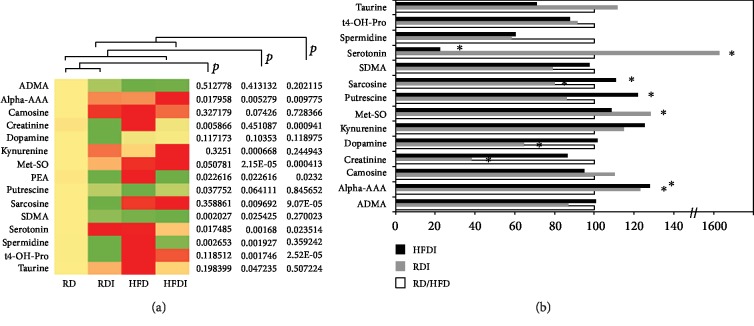
Comparison of biogenic amines profiling between T. cruzi-infected and uninfected mice fed on different diets at 150 DPI. (a) Heat map representing the serum levels of various biogenic amines during chronic infection in mice fed on either a RD or a HFD compared to uninfected RD mice at 150 DPI. Each row represents data for a specific metabolite, and each column represents the RD-fed uninfected (RD), RD-fed infected (RDI), HFD-fed uninfected (HFD), or HFD-fed infected (HFDI) mouse group. Different colors correspond to the different intensity level of metabolites (red > the control RD group and green < the control RD group). Statistically significant differences were tested using Student's t-test, and the corrected p values (q-value) are presented next to the heat map. Red, yellow, and green rectangles indicate high, moderate, and low expressions, respectively. (b) The percentage changes in the levels of biogenic amines in infected mice compared to the respective diet-fed (RD and HFD) uninfected mice represented by a bar graph (∗significant change).